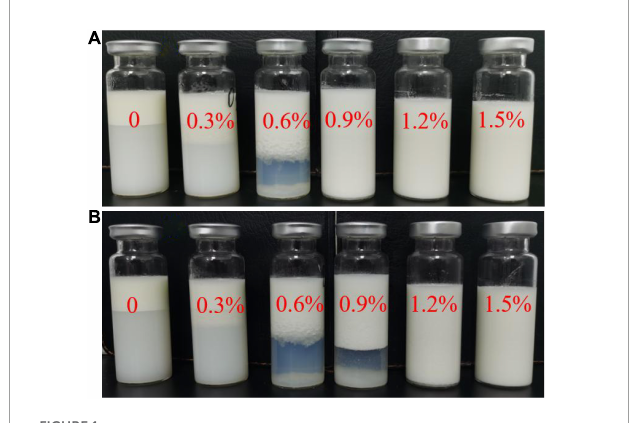
FIGURE1 The visual observations of emulsions with different concentrations of compound fibers. (A,B) Represent the emulsions after storage at 4 ◦ C for 2 h and 7 d,